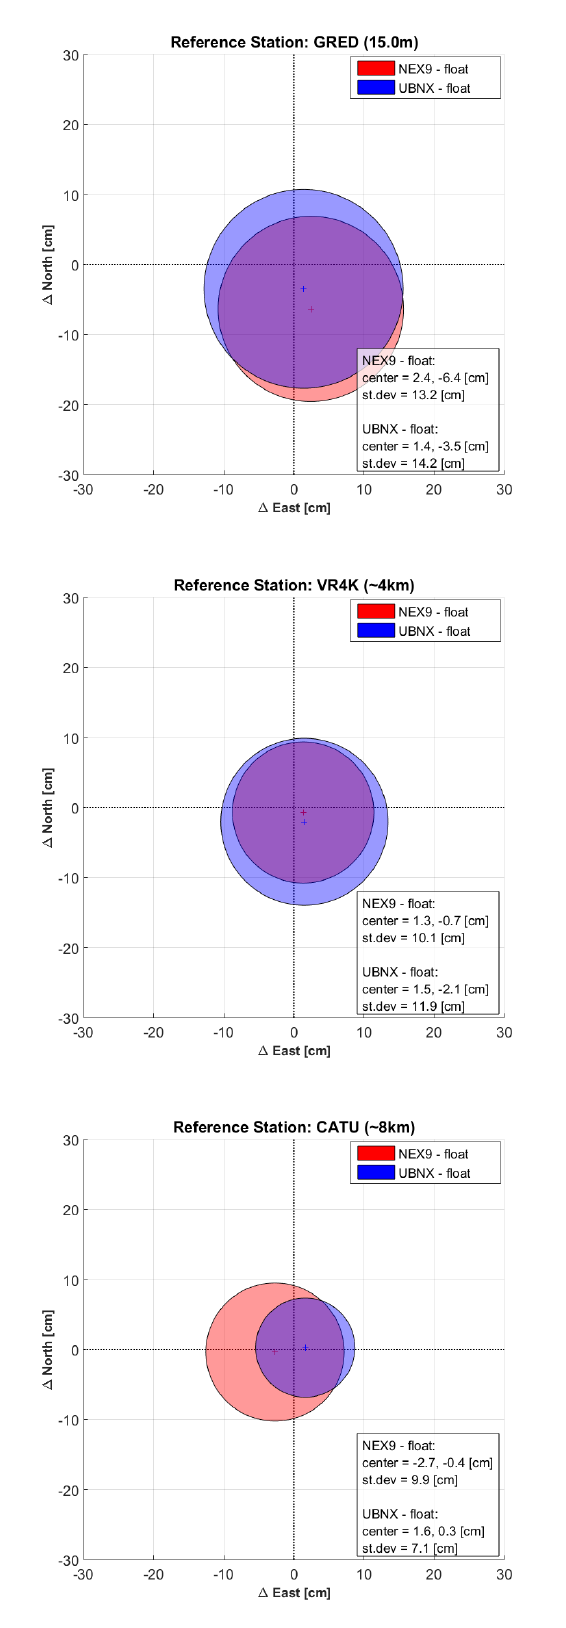
Figure 3. Bias (crosses) and 1-sigma dispersion (circles) of the differences between the 15-min float baselines of NEX9 and UBNX and their respective 1.5-h